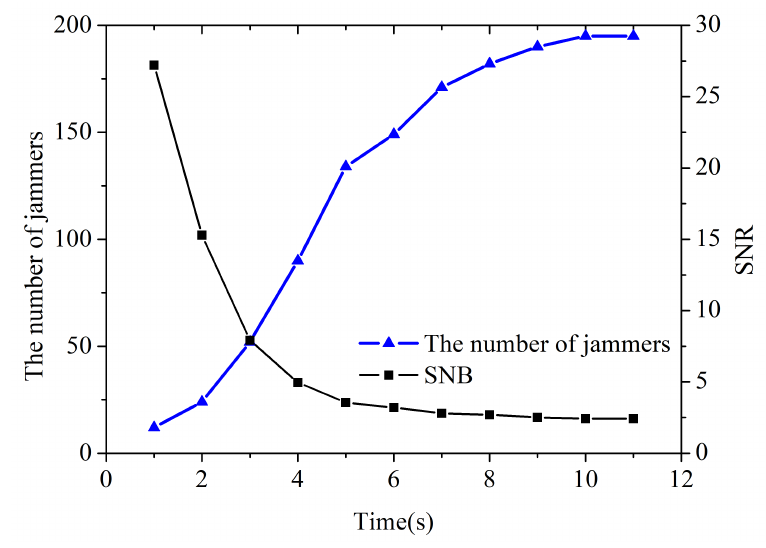
Figure 9. The influence of the number of jammers on the system SNR.